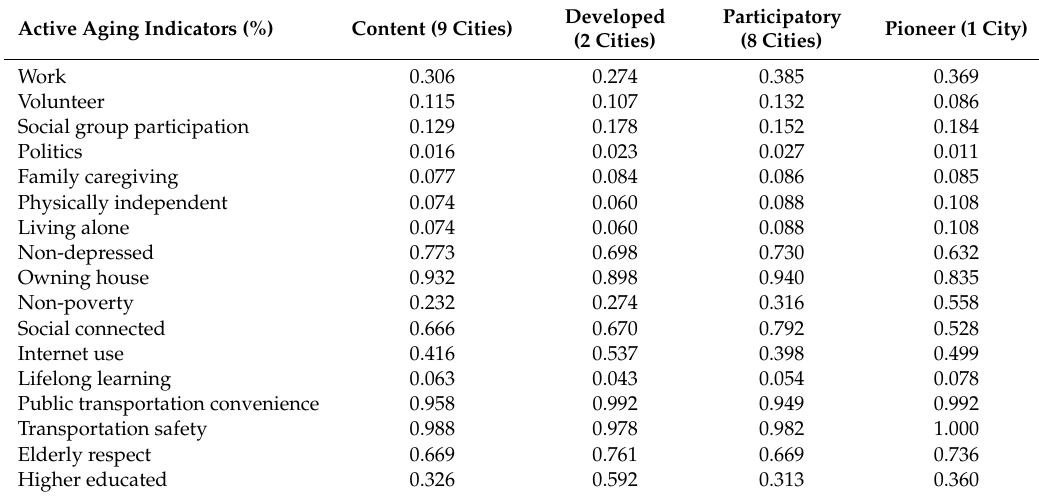
Table 2. City clusters of active aging indicators.